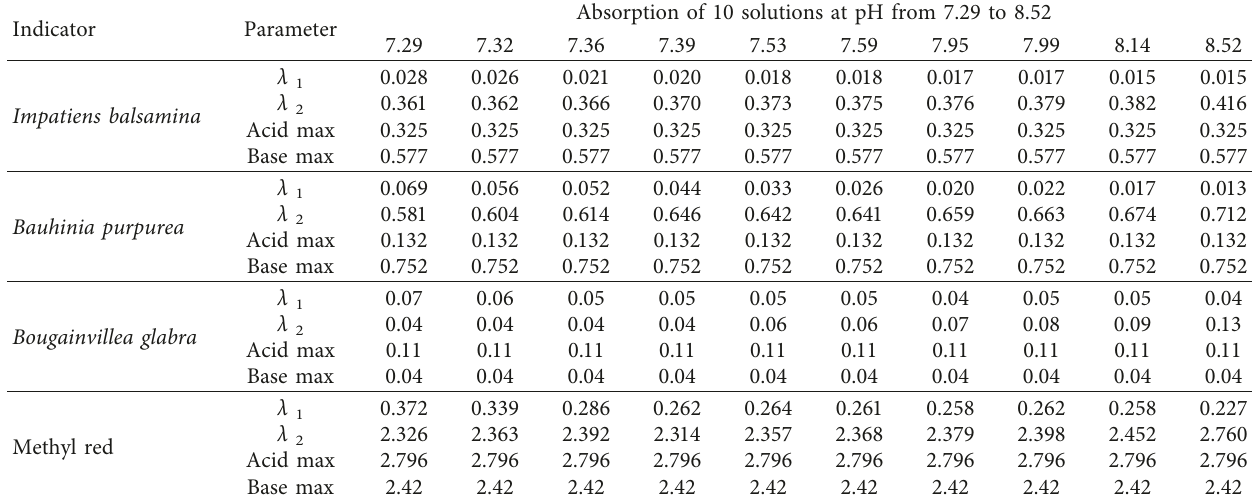
Table 2: Absorption of 10 solutions at pH 7.29, 7.32, 7.36, 7.39, 7.53, 7.59, 7.95, 7.99, 8.14, and 8.52 for all the three follower extracts and methyl red indicator.